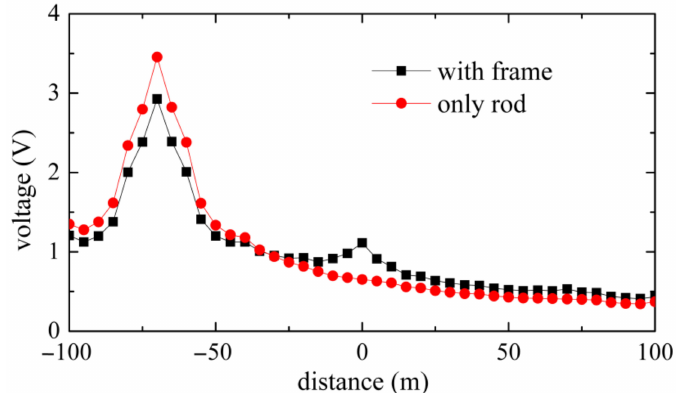
Figure 8. Peak of the potential along Line